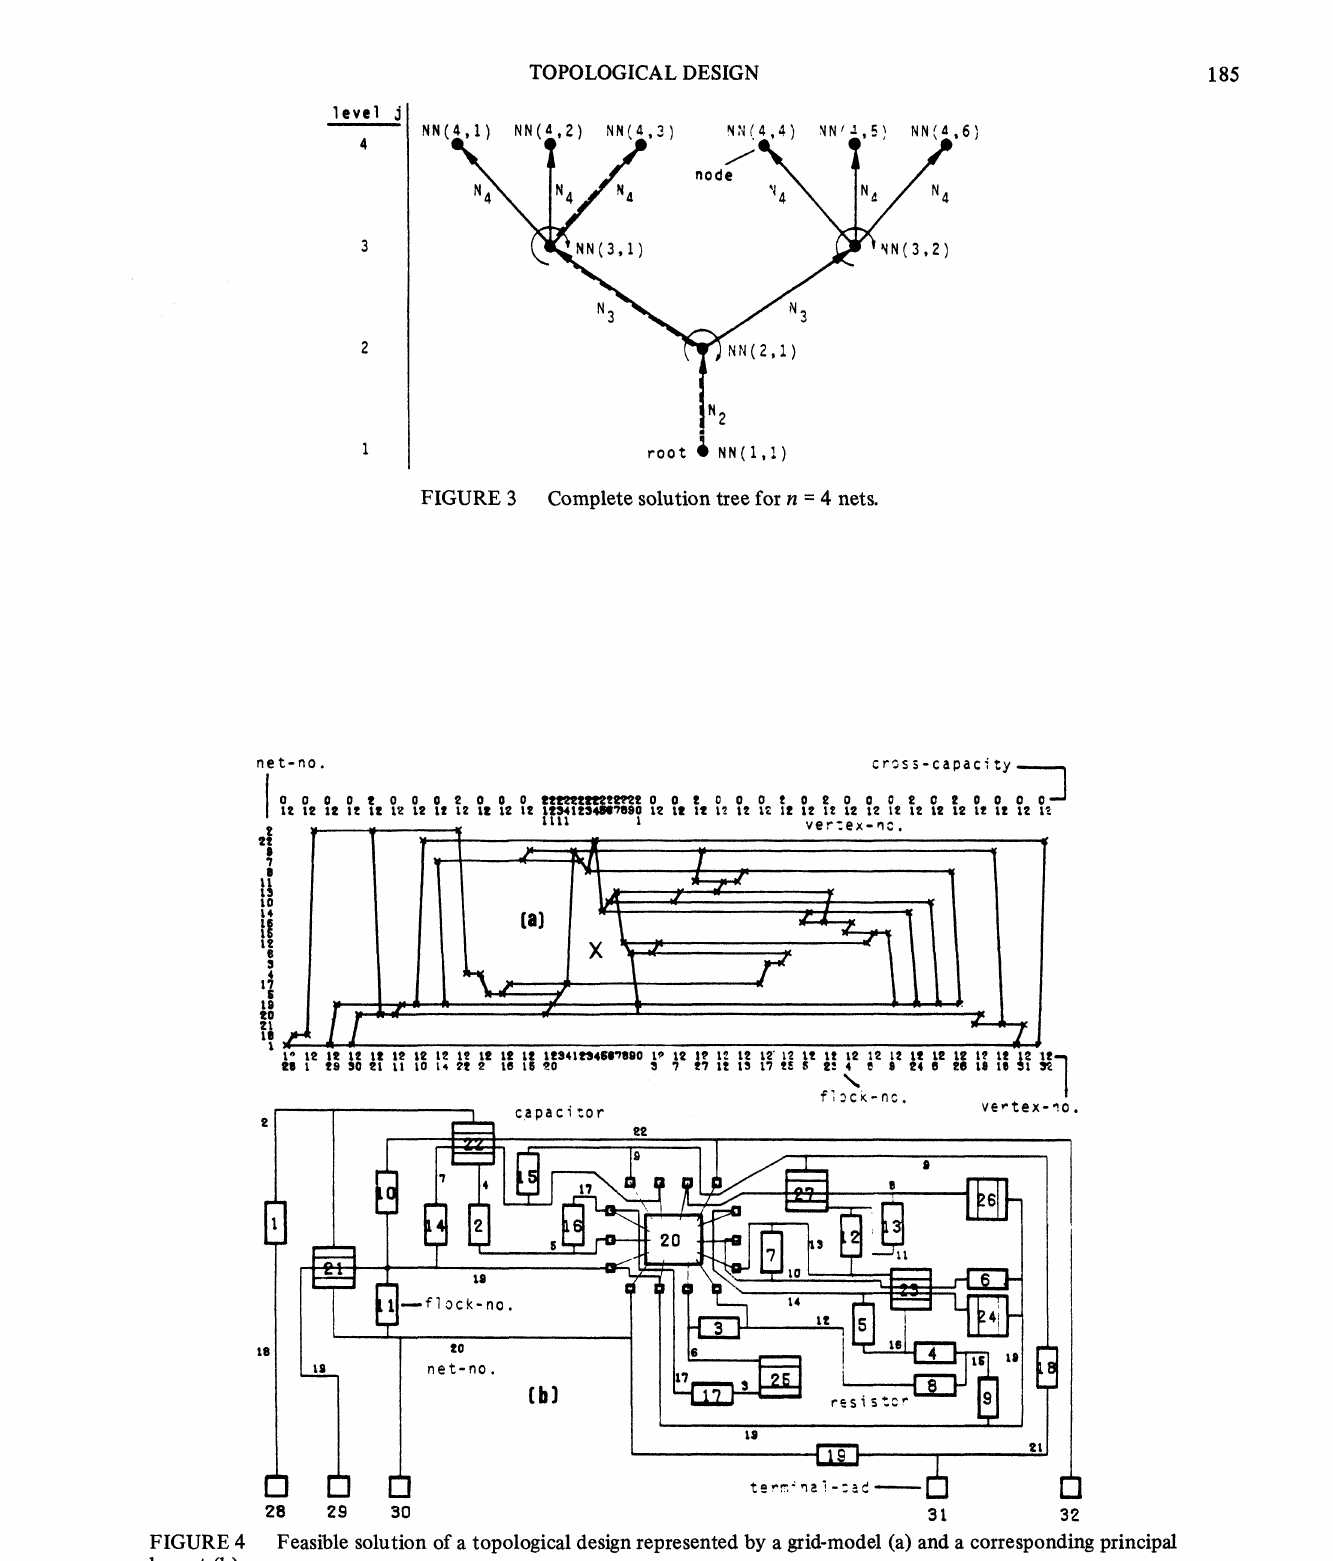
FIGURE 4 layout (b).